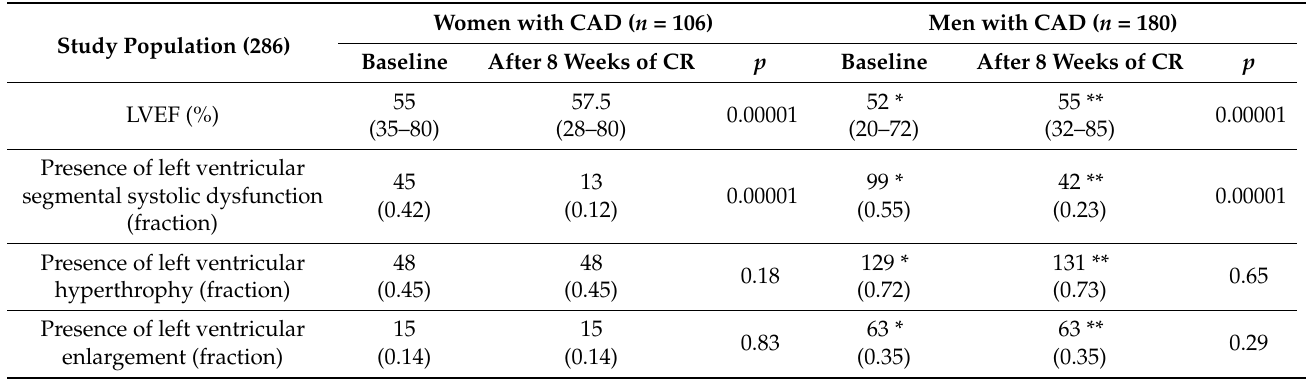
Table 2. Echocardiographic parameters of women and men with CAD at baseline and after 8 weeks of CR program.